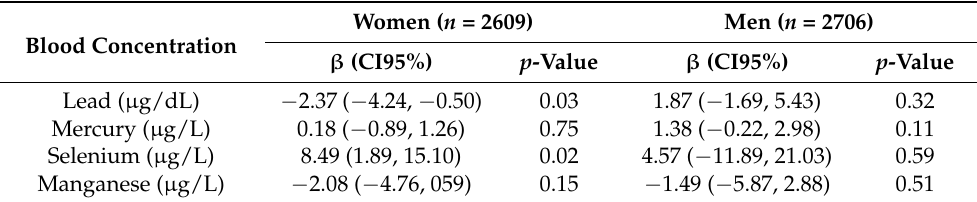
Table 4. Change in grip strength for a 10-fold increase in the concentration of each blood element in men and